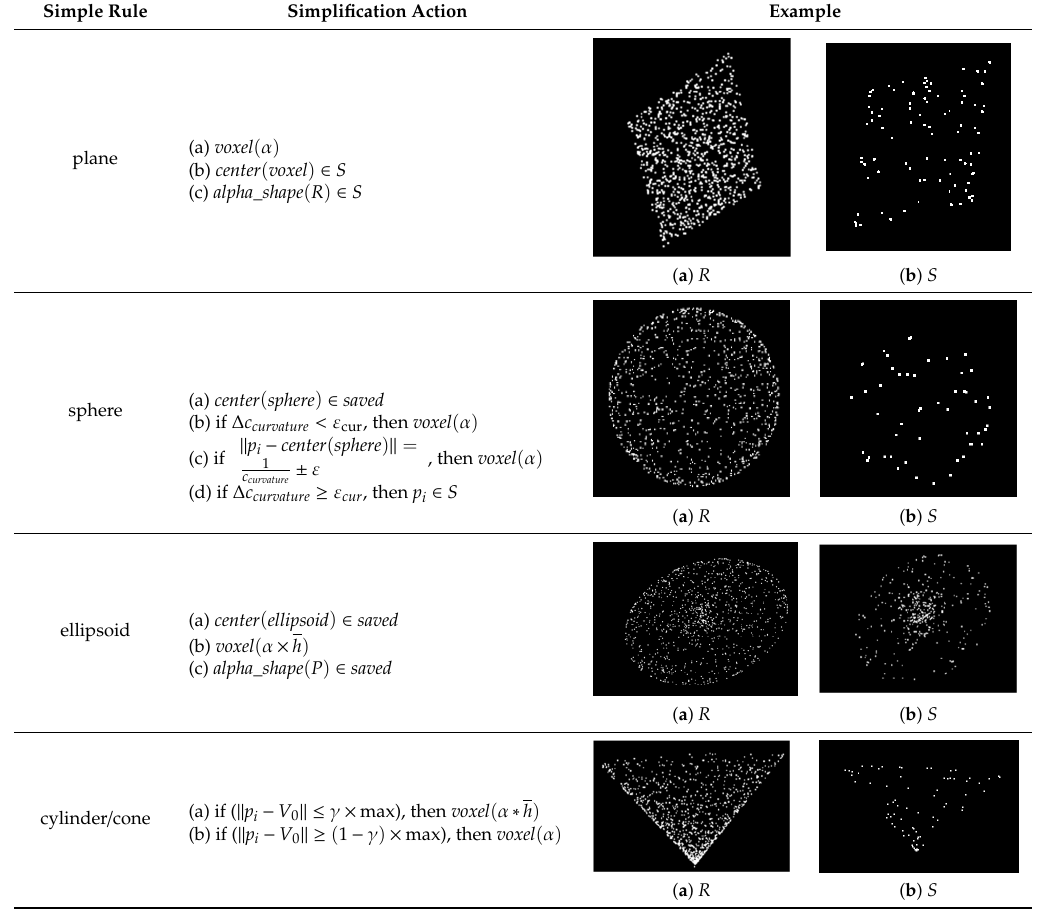
Table 1. Simplification Rules.